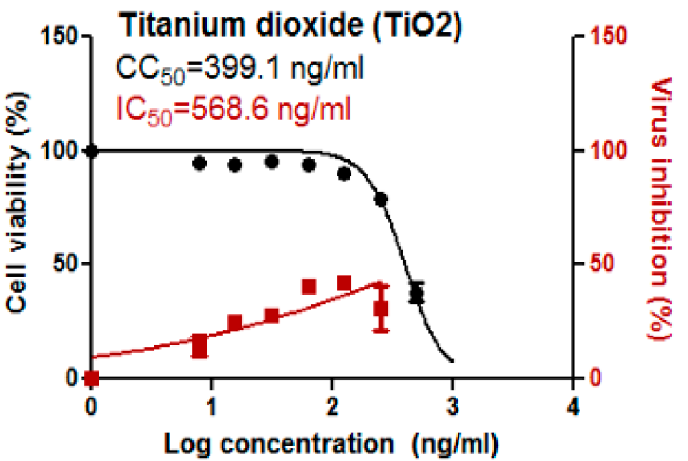
Figure 8. Titanium nanostructures (TiO 2 -NPs) cytotoxicity and inhibatory concentration against emerging corona virus (SARS-CoV-2) activity. Graph of Cytotoxicity concentration 50 (CC 50 ): on Vero E6 cells. Graph of Inhibitory concentration 50 (IC 50 ): Antiviral activity against Severe Acute. Respiratory Syndrome Coronavirus 2 (SARS-CoV-2) (hCoV-19/Egypt/NRC-03/2020.